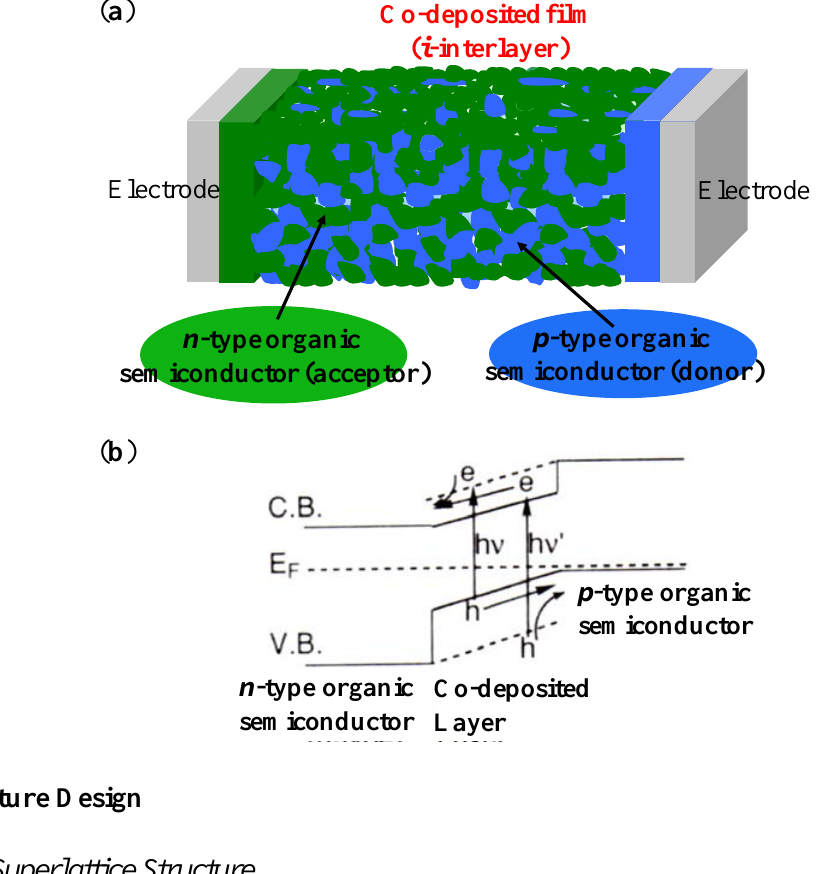
Figure 4. ( a ) Concept of p-i-n cell. A mixed i -layer co-deposited with n - and p -type semiconductors is sandwiched between respective p - and n -type layers. The entire bulk of the i -layer acts as an active layer for photocarrier generation; ( b ) Energy structure of the p-i-n